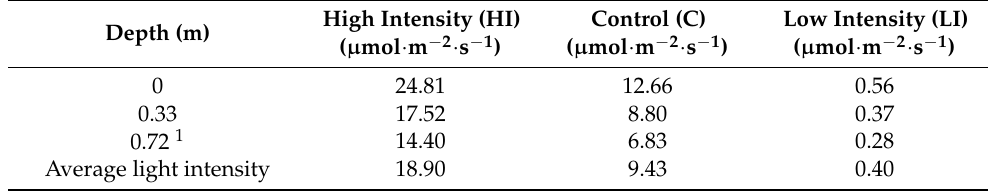
Table 1. Light intensities measured in the three tanks at three depths and average